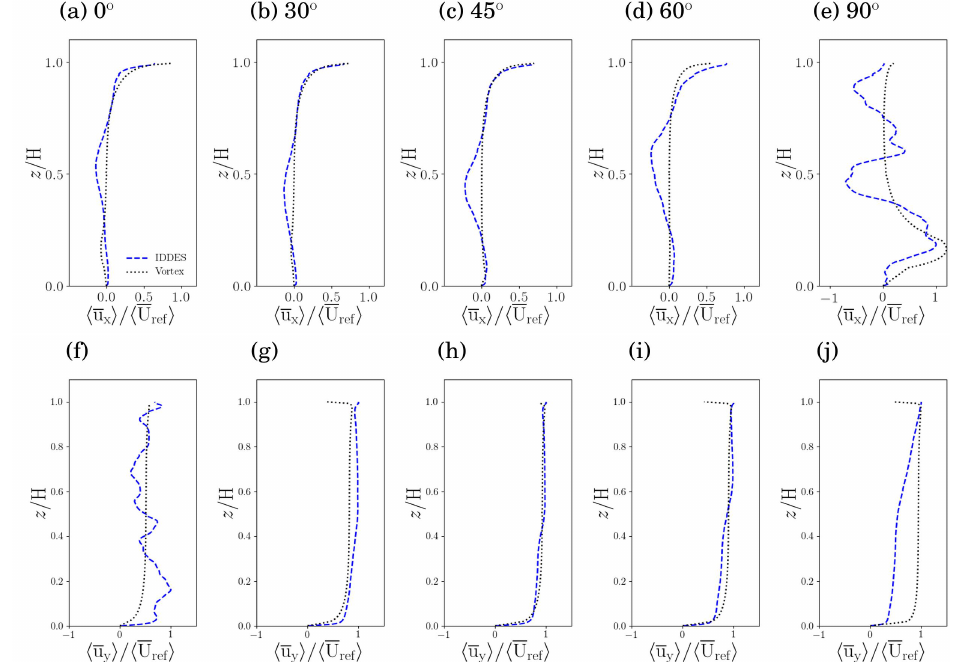
Figure 7. Vertical profiles of normalised velocities for the deep canyon ( AR = 3) and various θ . Mean streamwise ( top ) and spanwise ( bottom ) profiles are shown for the vortex method (dotted black line) and IDDES (dashed blue line). ( a , f ) θ = 0°; ( b , g ) θ = 30°; ( c , h ) θ = 45°; ( d , i ) θ = 60°; ( e , j ) θ = 90°. The mean streamwise velocity at z / H = 1 is used for the normalisation.